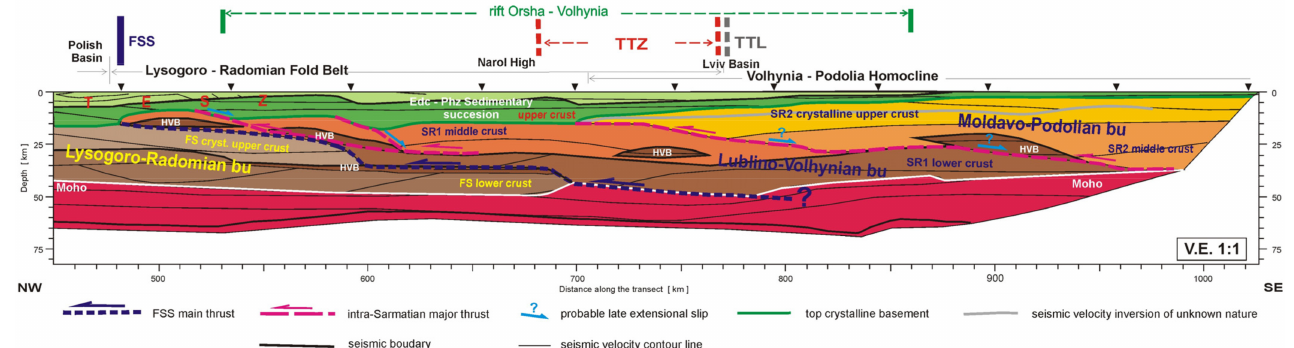
Figure 14. True-scale, schematic tectonic section showing structural geometry of extensive NW- vergent, wedge-shaped, flat-lying, crustal-scale thrust units composing the crystalline basement of the East European craton at and SE of the junction between the Fennoscandian and Sarmatian crustal segments. Abbreviations: bu—basement unit; Edc—Ediacaran; FS—Fennoscandia; FSS— Fennoscandia-Sarmatia suture; HVB—high-velocity body; Phz—Phanerozoic; SR—Sarmatia (with numbers 1 and 2 denoting crustal variations in distinct tectonic units); TESZ—Trans-European Suture zone. Thin solid lines within particular crustal layers are V p contours from the seismic model; the thick line in the uppermost mantle follows a refractive/reflective